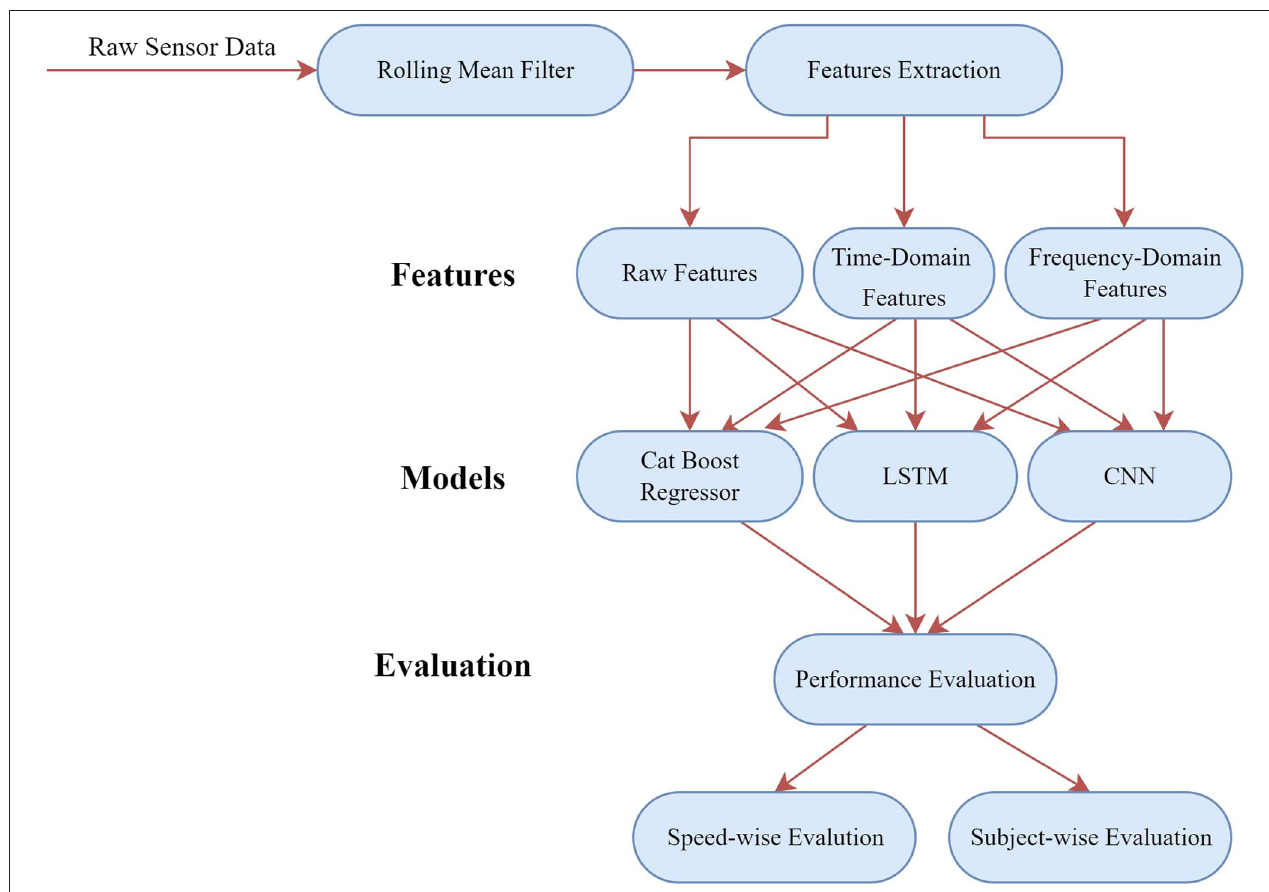
FIGURE 1 | An overview of the signal processing steps conducted in this study.